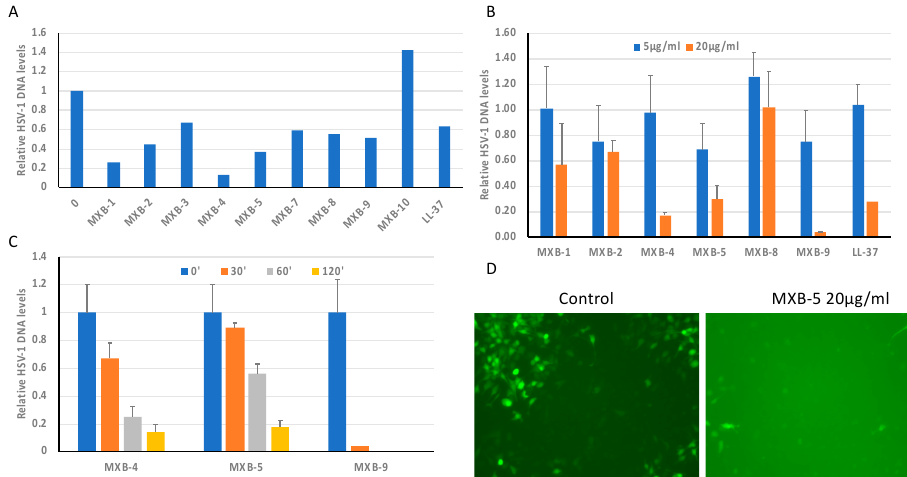
Figure 2. Activity of peptoids and of LL-37 against HSV-1. ( A ) Screening of peptoids against HSV, with comparison to the antiviral activity of LL-37, which is known to be active against HSV-1. The virus was treated with peptoids at 20 µg/mL for 2 h at 37 °C, followed by infection of OKF6/TERT1 cells for 24 h. Total DNA was isolated and HSV-1 DNA was quantified by QPCR relative to β -actin. ( B ) Activity of peptoids MXB-4, MXB-5 and MXB-9 at 5 µg/mL and 20 µg/mL for 2 h. ( C ) Time course of MXB-4, MXB-5 and MXB-9 activity. ( D ) Fluorescence imaging of HSV-1 infection 24 h. after treatment with either control (media) or MXB-5 (20 µg/mL for 2 h). Results shown are representative of at least two independent experiments.